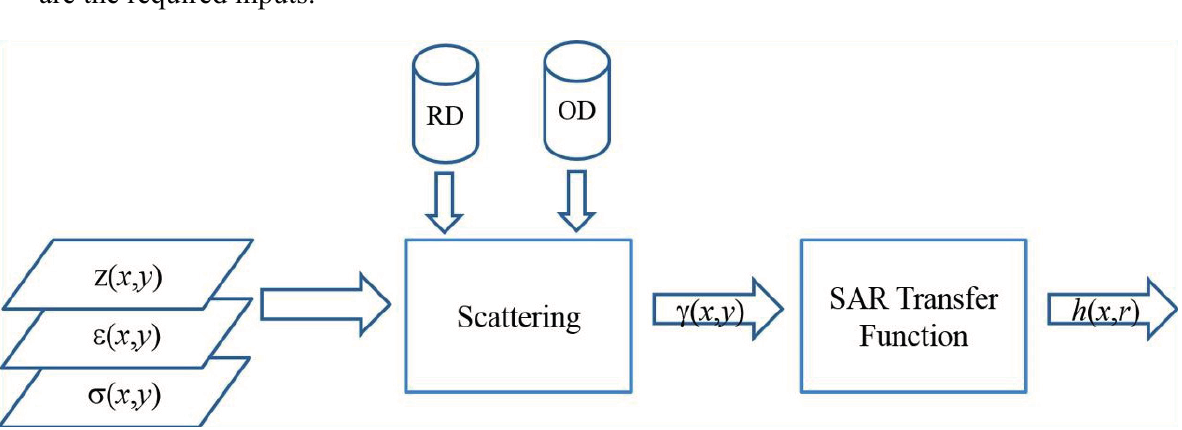
Figure 2. Block diagram of the SAR raw signal simulation. Radar (RD) and orbital (OD) data, along with the geometric ( z ) and electromagnetic ( ε and σ ) parameters of the surface are the required inputs.